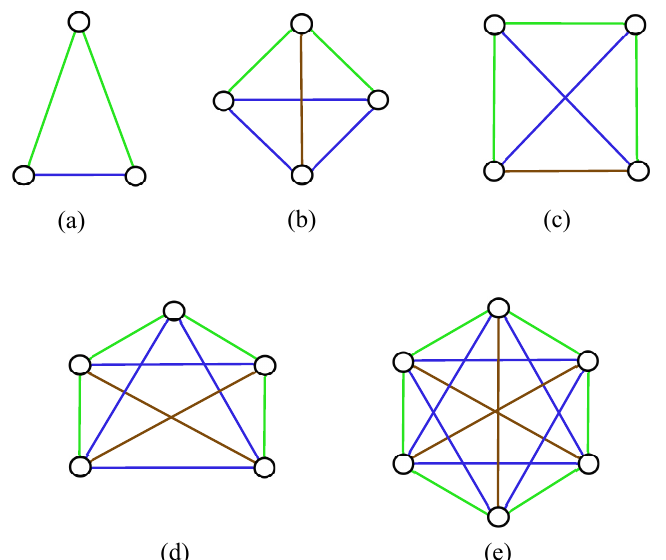
Figure 8. Five possible components of the subgraph G D in which there are two adjacent edges with weights 1. Green, blue, brown, and black correspond to the values 1, 2, 3, and 4, respectively. ( a ): the complete graph K 3 with edge weights 1, 1, and 2; ( b ): the complete graph K 4 with edge weights 1, 1, 2, 2, 2, and 3; ( c ): the complete graph K 4 with edge weights 1, 1, 1, 2, 2, and 3; ( d ): the complete graph K 5 ; ( e ): the complete graph K 6